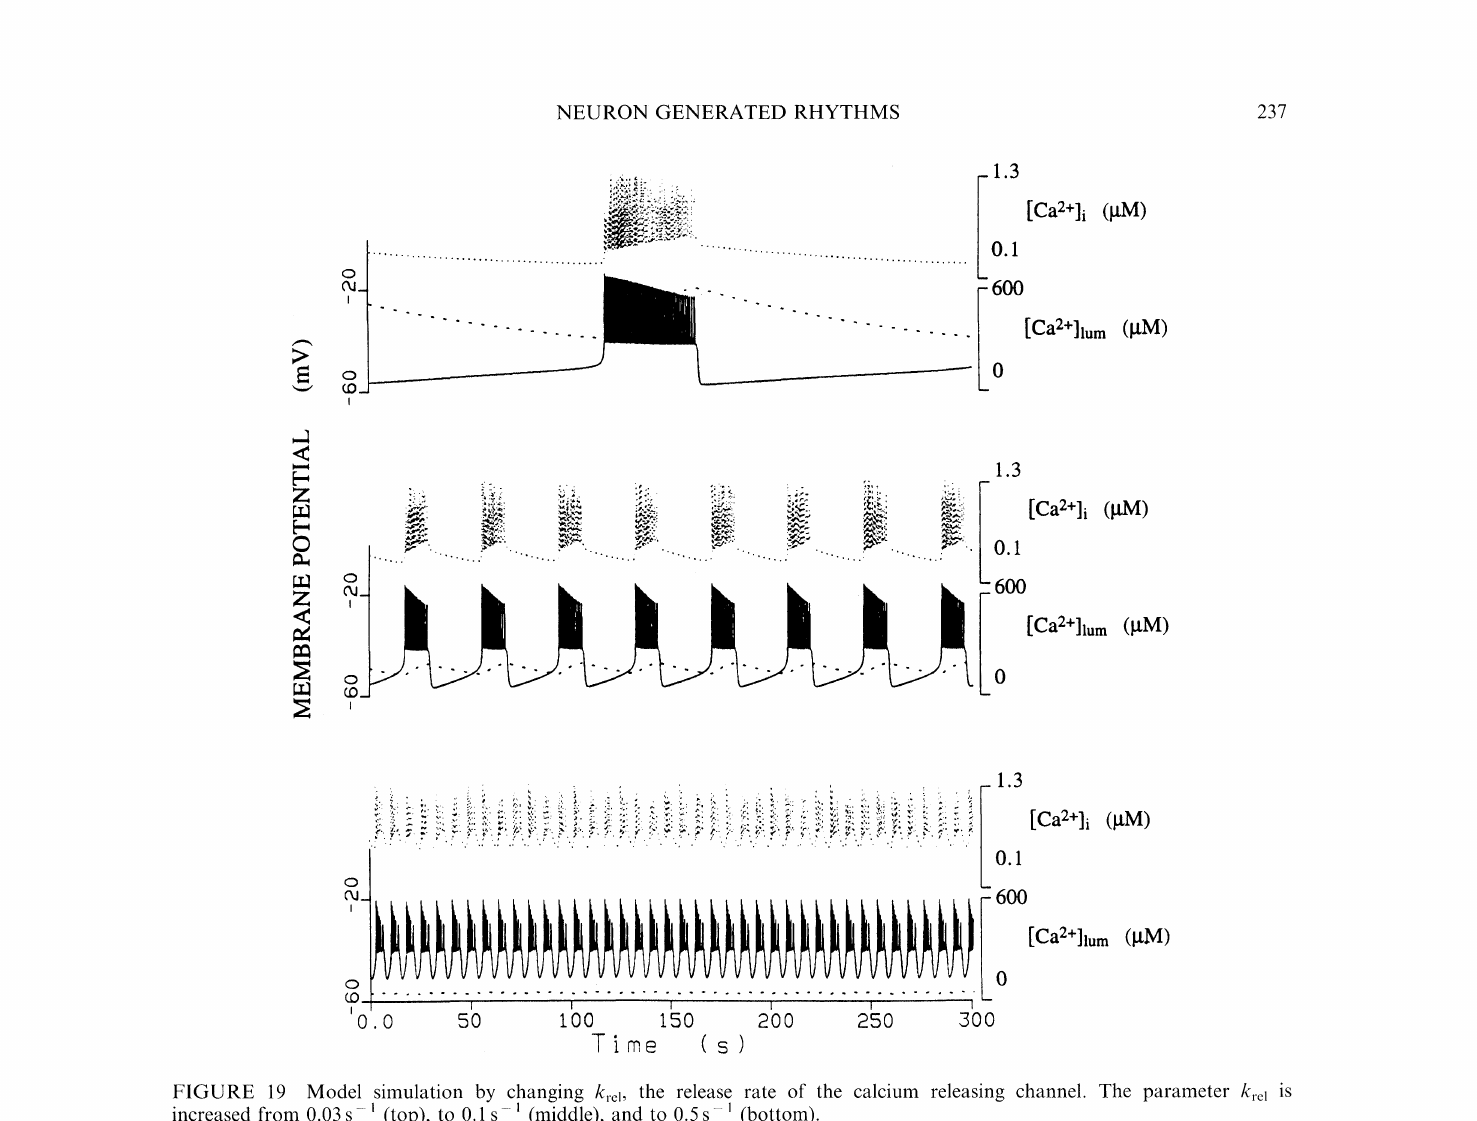
FIGURE 19 Model simulation by changing krl, the release rate of the calcium releasing channel. The parameter krol is increased from 0.03 s- (top), to 0.1 s- (middle), and to 0.5 s-